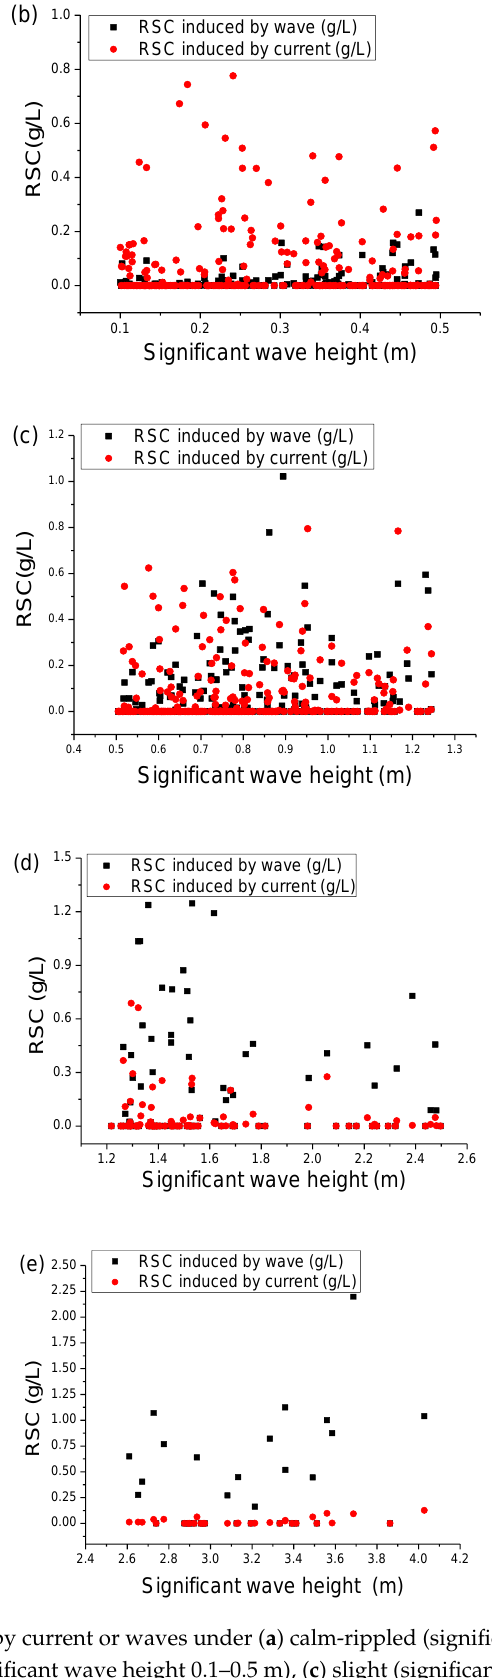
Figure 10. RSC induced by current or waves under ( a ) calm-rippled (significant wave height 0–0.1 m), ( b ) smooth-wavelet (significant wave height 0.1–0.5 m), ( c ) slight (significant wave height 0.5–1.25 m), ( d ) moderate (significant wave height 1.25–2.5 m), and ( e ) rough (significant wave height 2.5–4.0 m) sea